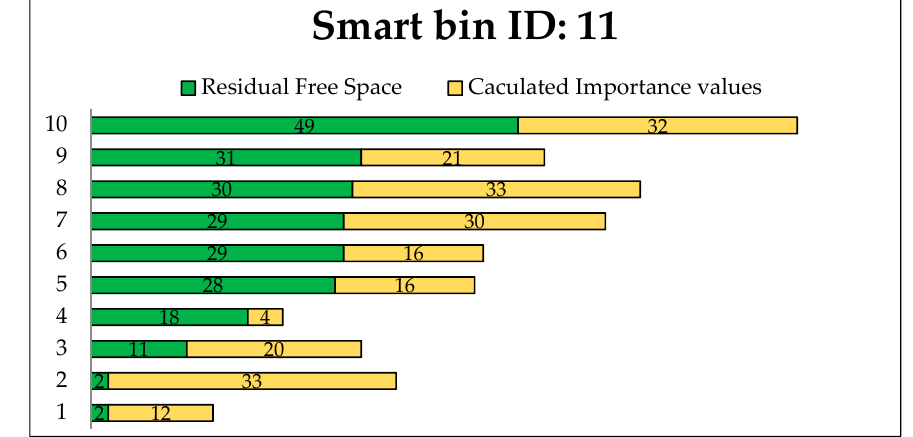
Figure 11. Evaluation routes to smart bin id: 11.